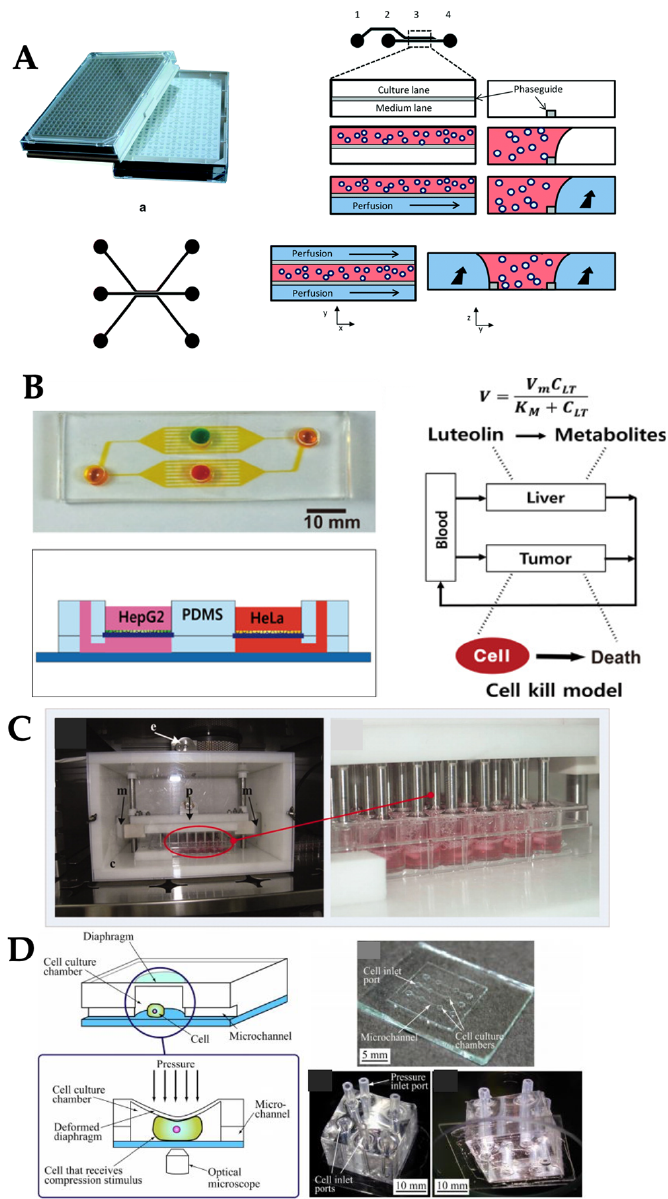
Figure 5. Examples of OOC systems with passive delivery and compression. ( A ) OrganoPlate was rocked to generate a passive flow through network of neurons. ( B ) Gravity flow machine generated flow to the liver and cervical cancer cells on chip. ( C ) Piston chamber generated compressive stress on the cardiac tissue within TCP. ( D ) Diaphragm and pressure controller generated compressive stress on osteoblastic cells on chip. Reproduced with permission from References [26,43,53,56].